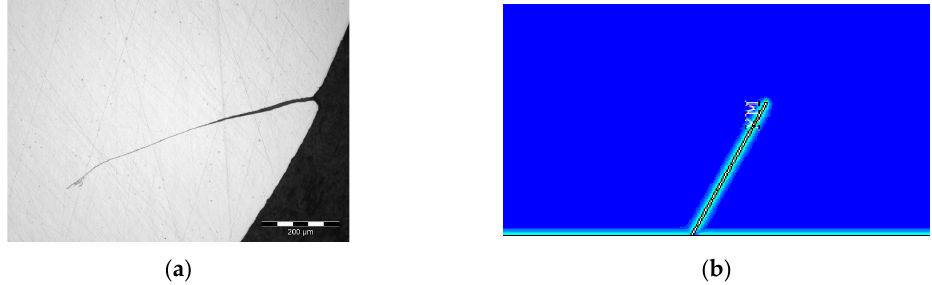
Figure 11. ( a ) Microscopic cross section of a rolling lap defect; ( b ) simulated Joule heating around a crack in a ferro-magnetic material, f = 200 kHz.